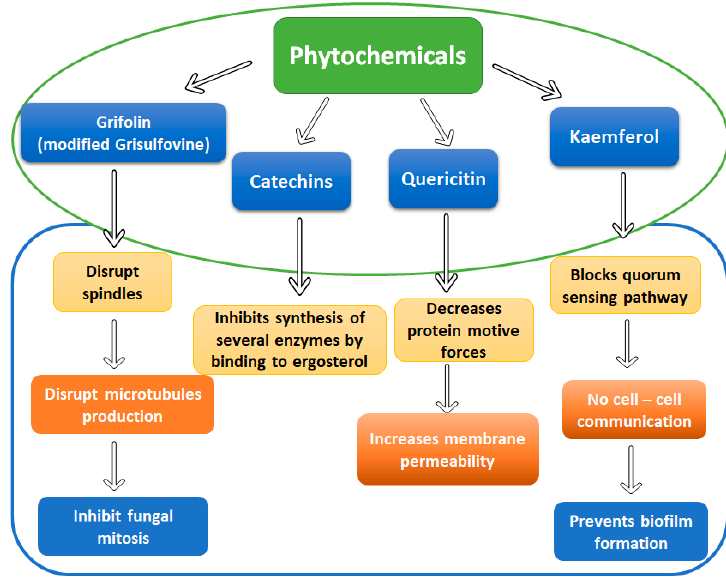
Figure 4. Mechanism of various phytochemicals as